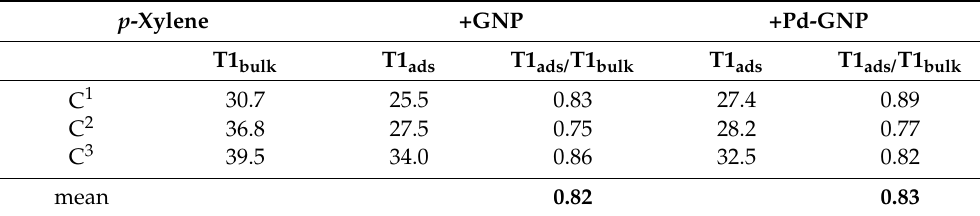
Table 6. p -Xylene T1 bulk and T1 ads resulting from analysis of the inversion recovery curves from 13 C NMR spectra (600 MHz).